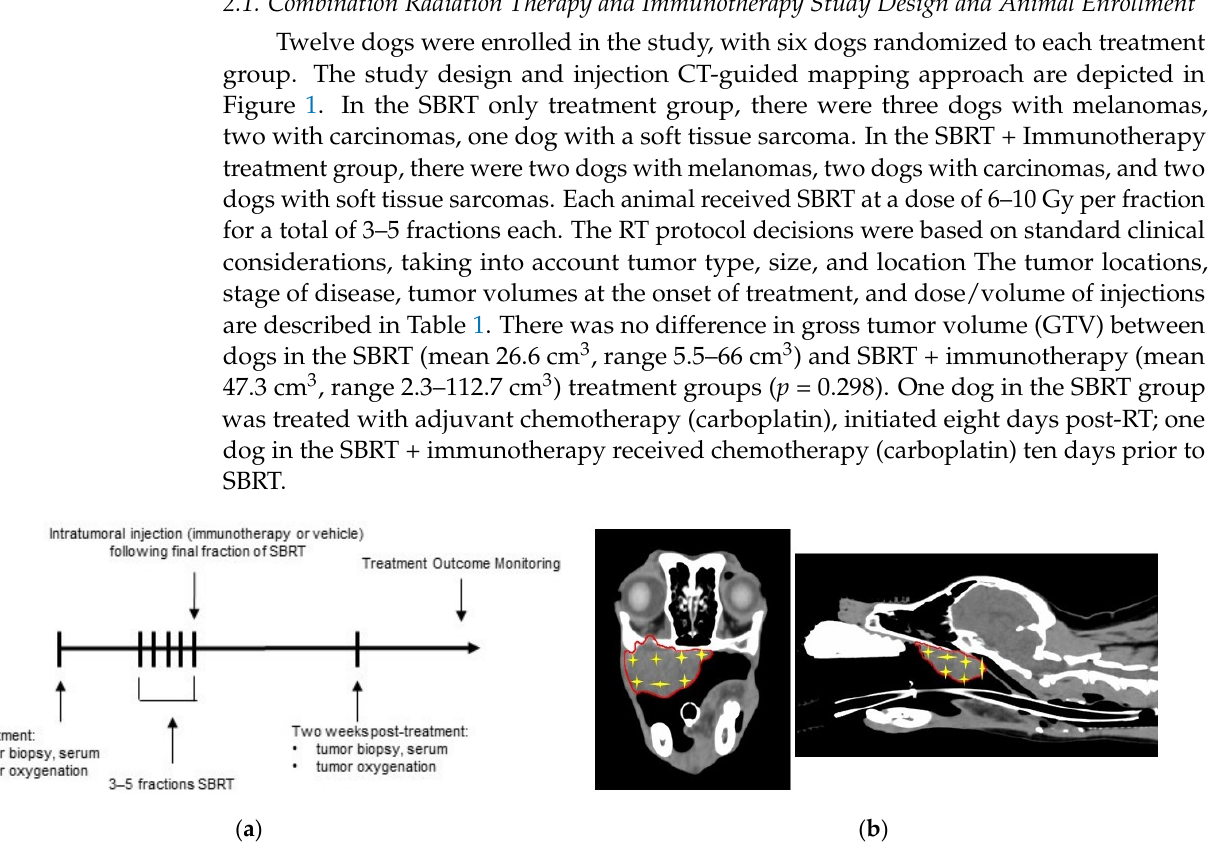
Figure 1. Combination radiation therapy and immunotherapy study design: ( a ) Dogs were random- ized into two treatment groups: (1) SBRT only and (2) SBRT and immunotherapy; serial tumor and serum samples were obtained and tumor oxygenation measurements were obtained prior to and two-weeks post treatment. ( b ) Representative images of a three-dimensional injection map which was prepared prior to injections for each dog in order to homogenously inject immunotherapy or vehicle (PBS). Red line outlines gross tumor volume; yellow stars indicate an injection site. Table 1. Signalment, disease characteristics, and treatment conditions of study